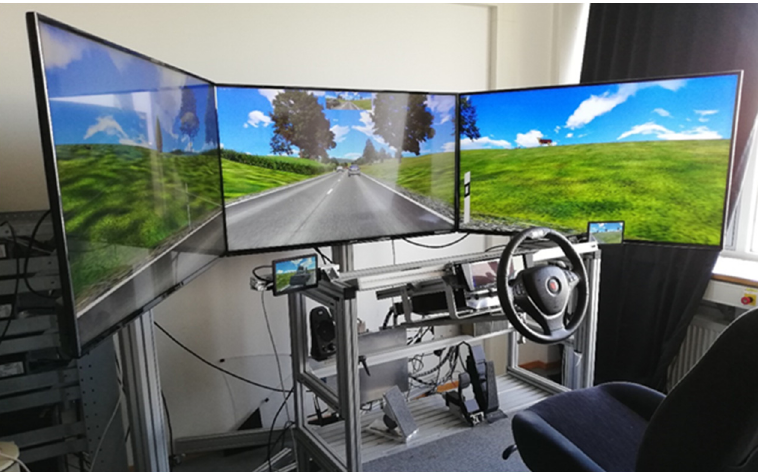
Figure 3. Structure of the static driving simulator.